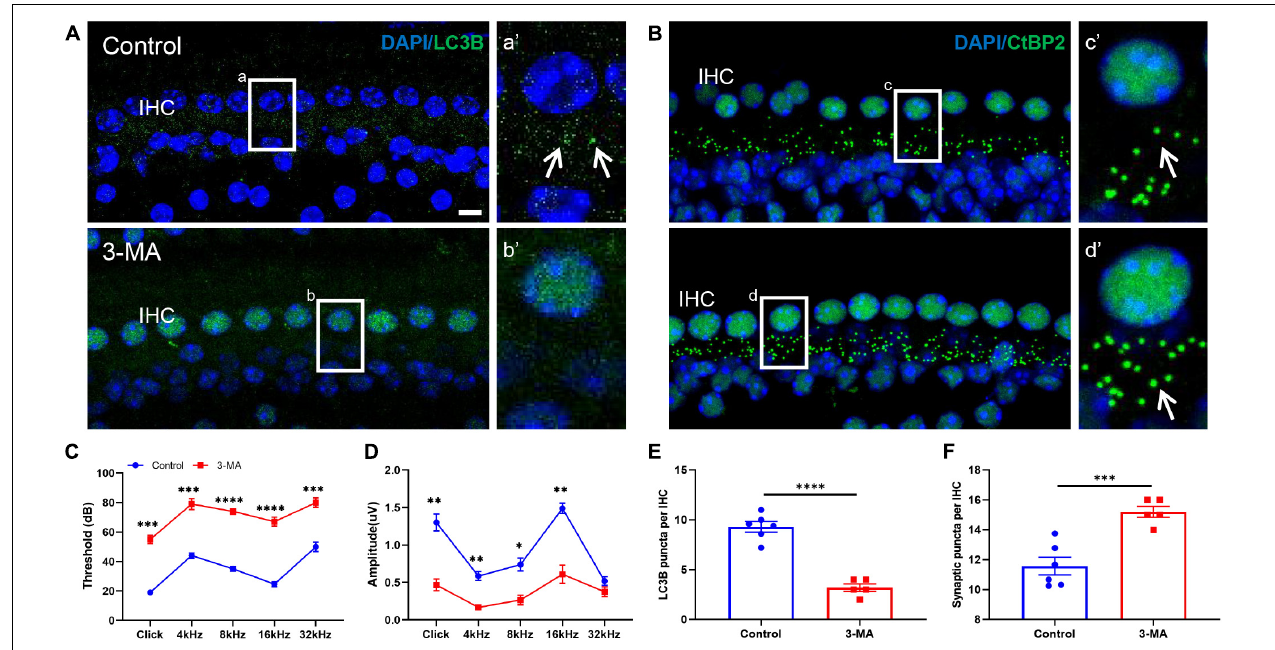
FIGURE 8 | Inhibiting autophagic activity in the developing cochlea increased the number of ribbon synapses but impaired hearing function. (A,a,b) and their respective enlarged images (a (cid:48) ,b (cid:48) ) show that 3-MA administration can cause a significant loss of LC3B-positive puncta compared with the controls. (B) Normal CtBP2 puncta (green) can be seen in the control group; the white frame indicates (c) ; (c (cid:48) ) is the enlarged image of panel (c) . 3-MA administration caused an increased number of CtBP2 puncta; the white frame indicates (d) , panel (d (cid:48) ) is the enlarged image of panel (d) . (C) ABR thresholds were significantly increased across frequencies in the 3-MA-administrated group compared with controls (*** p < 0.001; **** p < 0 . 0001). (D) Compared with the controls, a significant reduction in ABR wave I amplitude appeared in the 3-MA group at click, 4, 8, 16, and 32 kHz (* p < 0.05; ** p < 0.01). (E) A significant reduction in LC3B-positive puncta can be seen in the 3-MA group compared with the controls (**** p < 0.0001). (F) A significant enhancement in the number of ribbon synaptic spots can be seen in the 3-MA group compared with controls (*** p < 0.001). 3-MA, 3-methyladenine; ABR, auditory brainstem